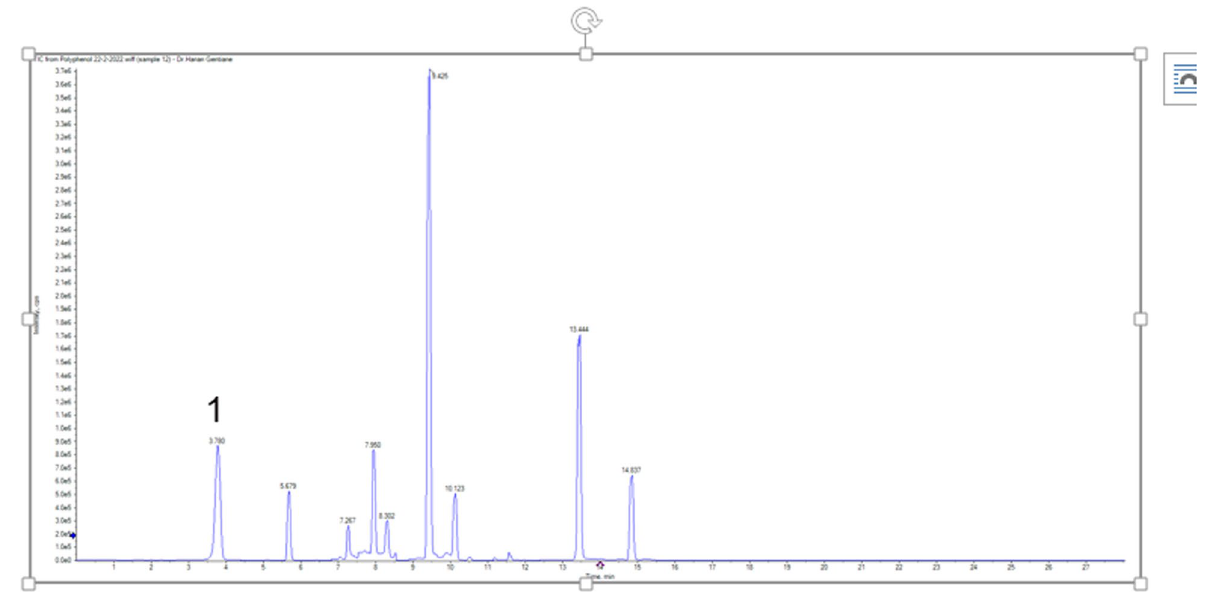
Fig. 6 HPLC–DAD chromatogram of the GEN extracts